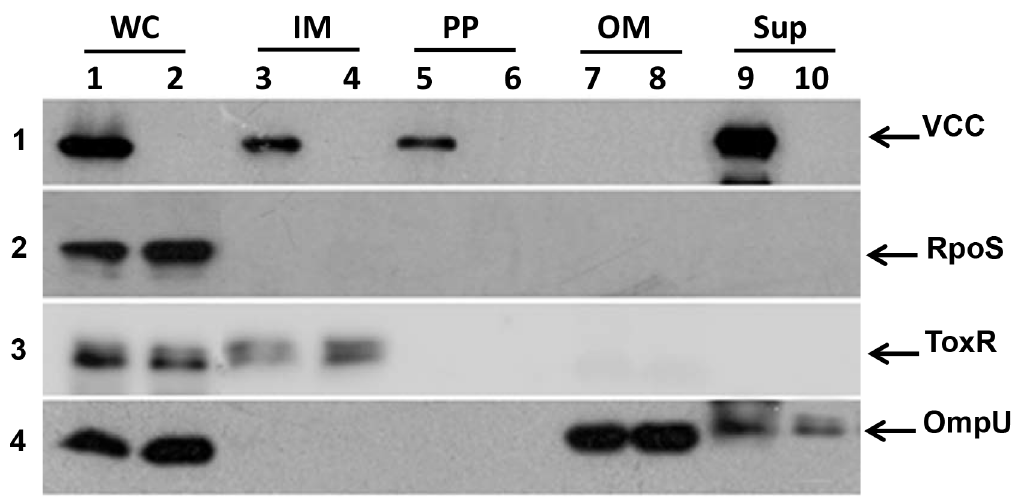
Figure 1. Immunoblot analysis of cell fractions. (A) Whole cell lysate (WC), Inner membrane (IM), periplasmic (PP), outer membrane (OM) fractions and culture supernatant (Sup) from the NOVC strain V:5/04 (lanes 1, 3, 5, 7, 9) and its isogenic D vcc mutant (MDS-1) (lanes 2, 4, 6, 8, 10), respectively. The samples were subjected to immunoblot analysis to detect VCC and different internal controls to rule out cross-contamination during fractionation; RpoS (as a cytoplasmic marker, panel 2), ToxR (as a inner membrane marker, panel 3), and OmpU (as an outer membrane marker, panel 4).